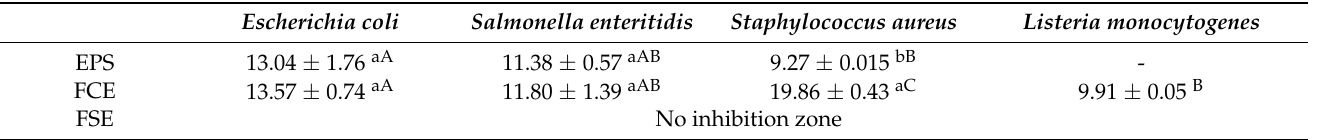
Table 8. Antibacterial effect (mm) of purified bacteriocin extract (EPS) and control bioplastic films (FSE) and incorporated bacteriocin (FCE) in front microbial tests.